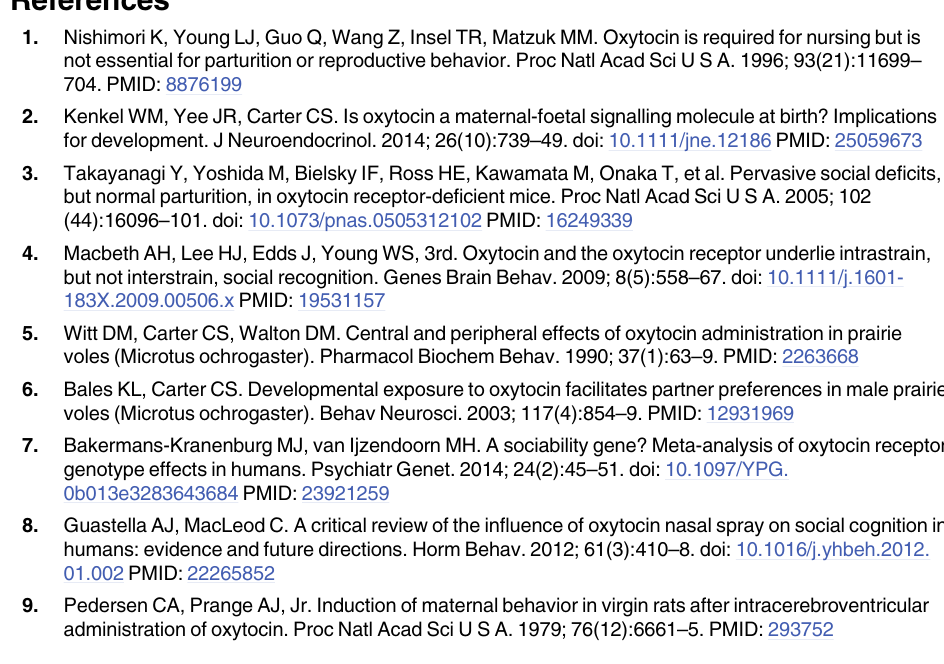
S1 Table. Densitometry data for all quantified